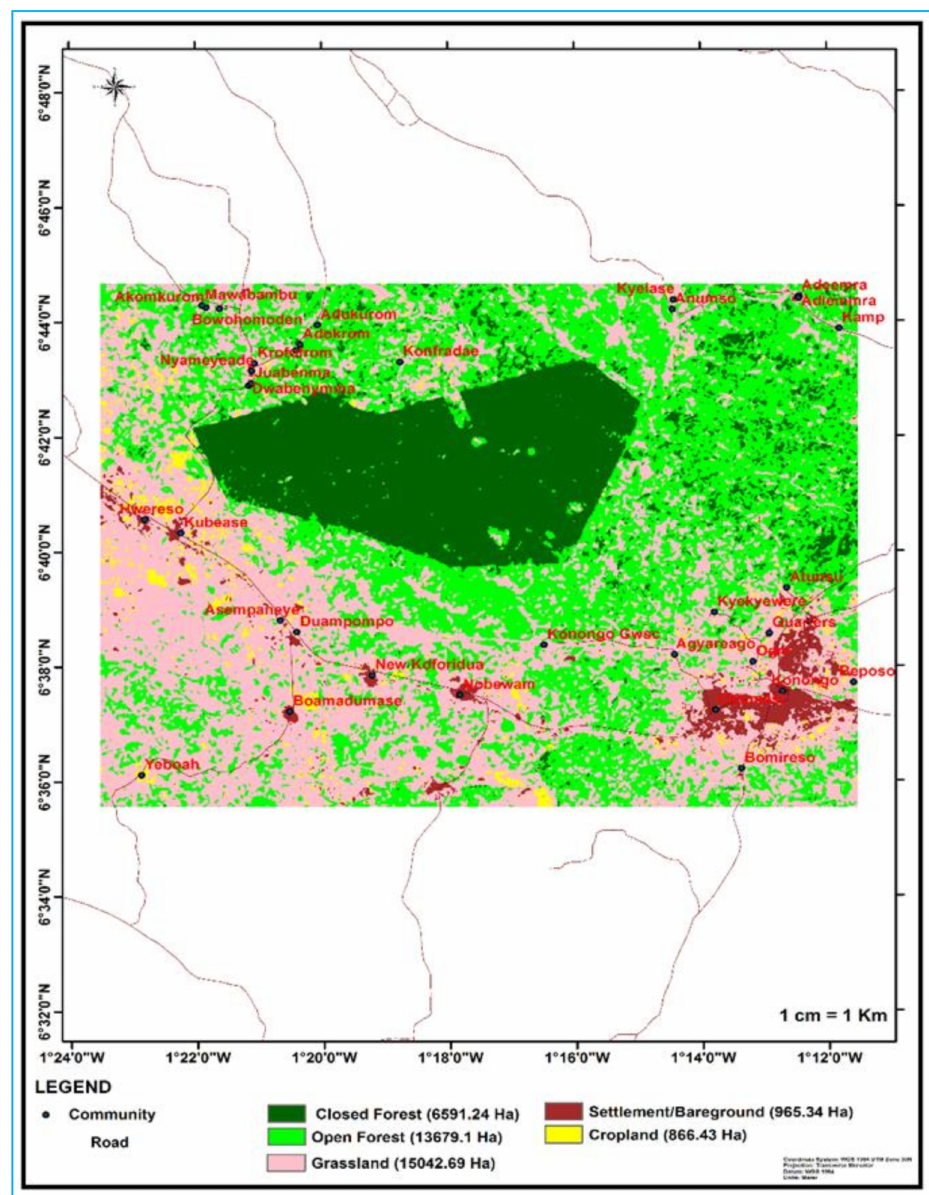
Figure 6. Landsat image of Bobiri forest reserve in 2010. Figure 7 shows the Landsat image for 2014. Settlement/bare ground gradually shot up to 3.6%. Crop land also increased marginally by 0.3%. But there was a massive reduction of the closed forest to 14.4%, and grassland continued to